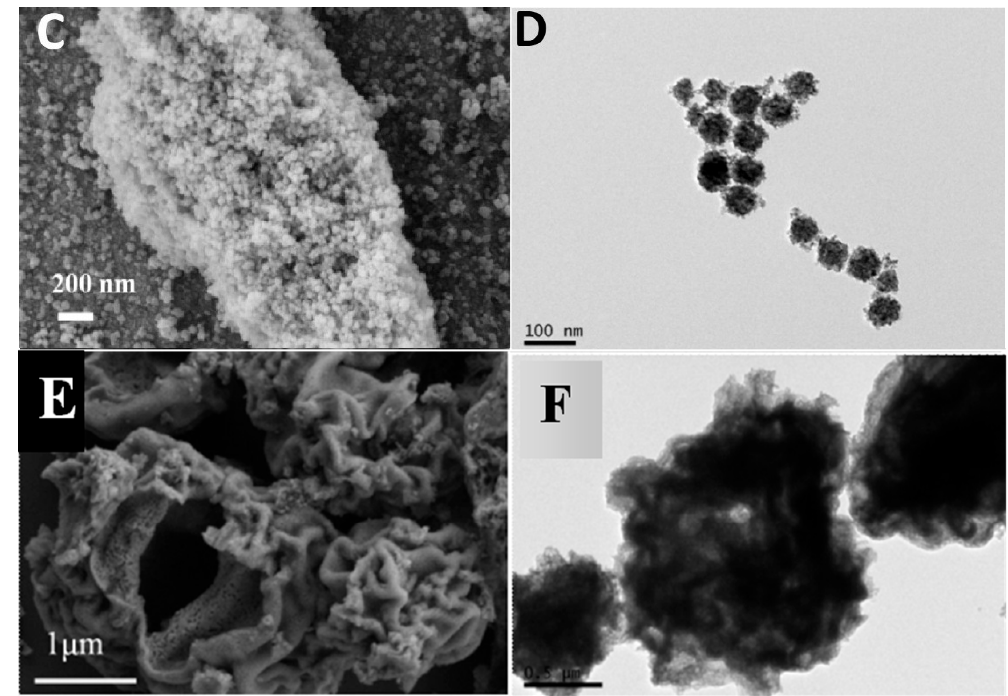
Figure 3. SEM and TEM images of ( A , B ) LaFeO 3 ; ( C , D ) CeO 2 ; ( E , F ) CeO 2 -LaFeO 3 .